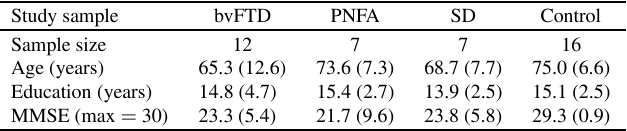
Table 1 Summary characteristics (mean and standard deviation) of